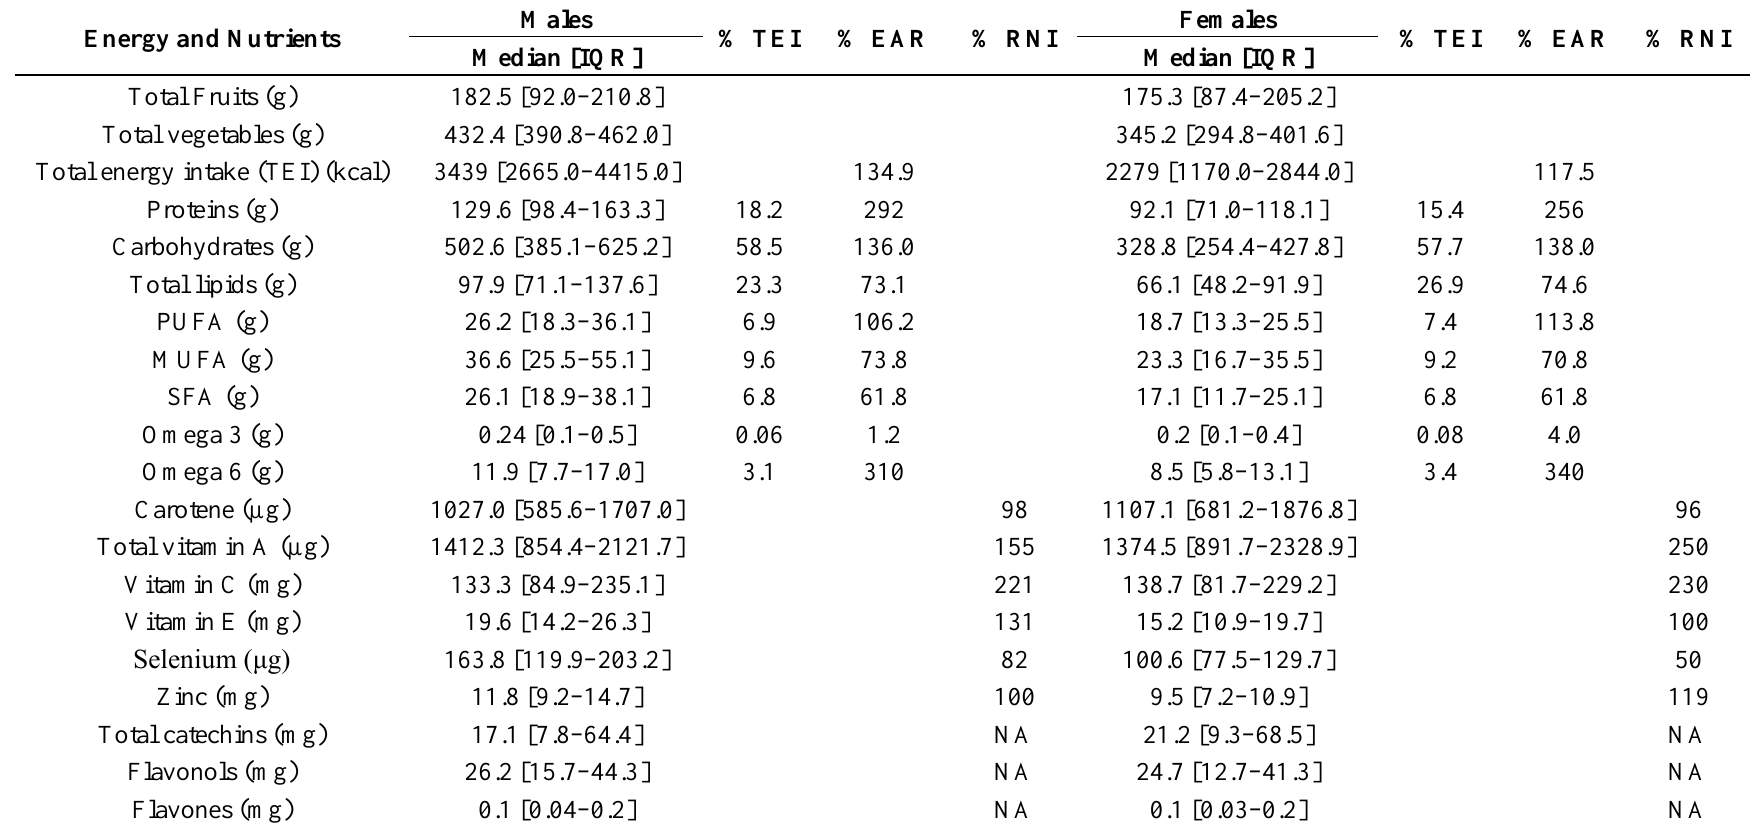
Table 2. Daily average dietary intake of foods and